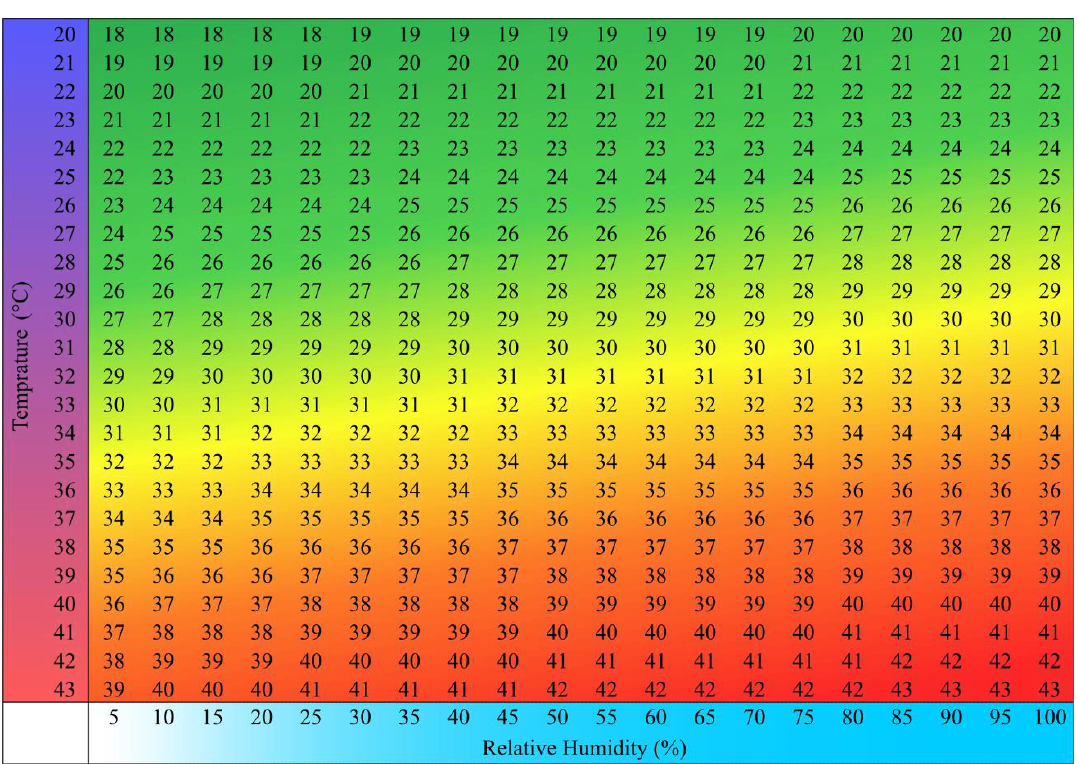
Figure 12. The sensible and latent heat production per poultry bird for ( a ) 18 °C, ( b ) 30 °C, ( c ) 40 °C, and ( d ) 45 °C.